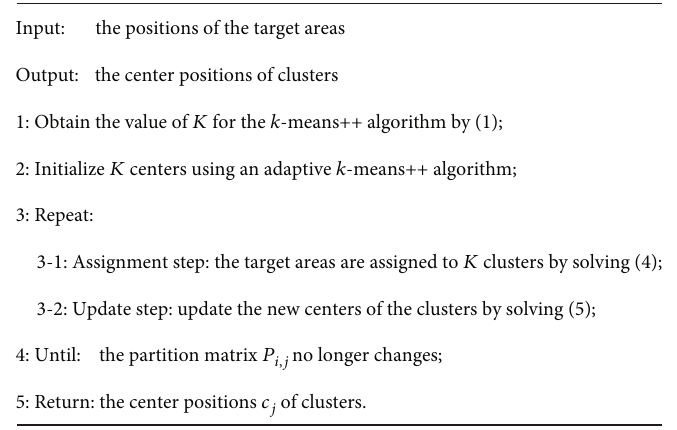
Figure 4: The proposed clustering method for the position selection of the relay